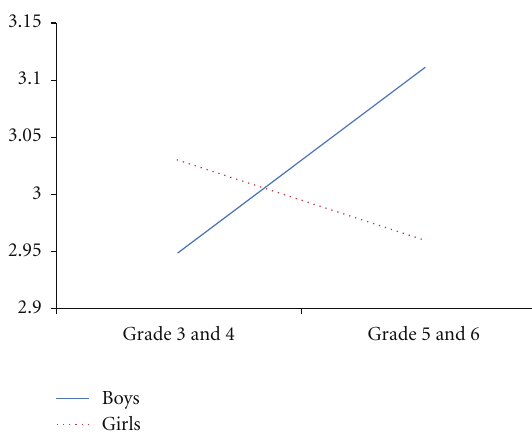
Figure 4: Sex by grade interaction for sporting